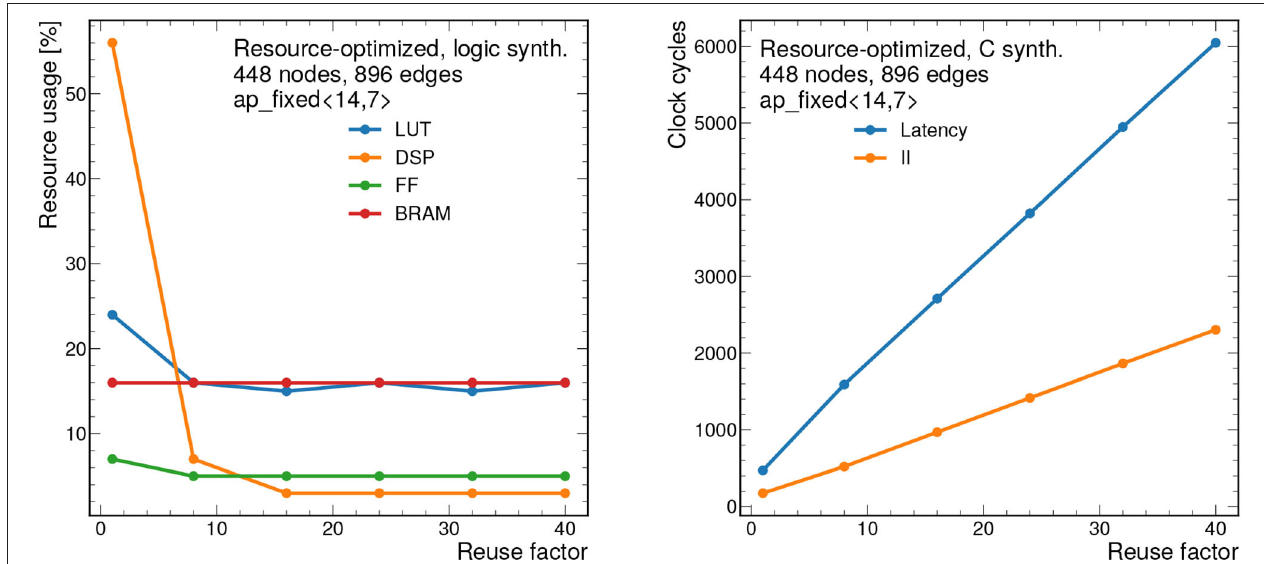
FIGURE 12 | Resource usage estimates as a percentage after logic synthesis (left) and latency and II in clock cycles (right) for a constant fixed point precision of ap_fixed<14,7> as a function of the reuse factor for the resource-optimized implementation. Input graphs consist of 448 nodes and 896 edges. Each clock cycle corresponds to 5ns.